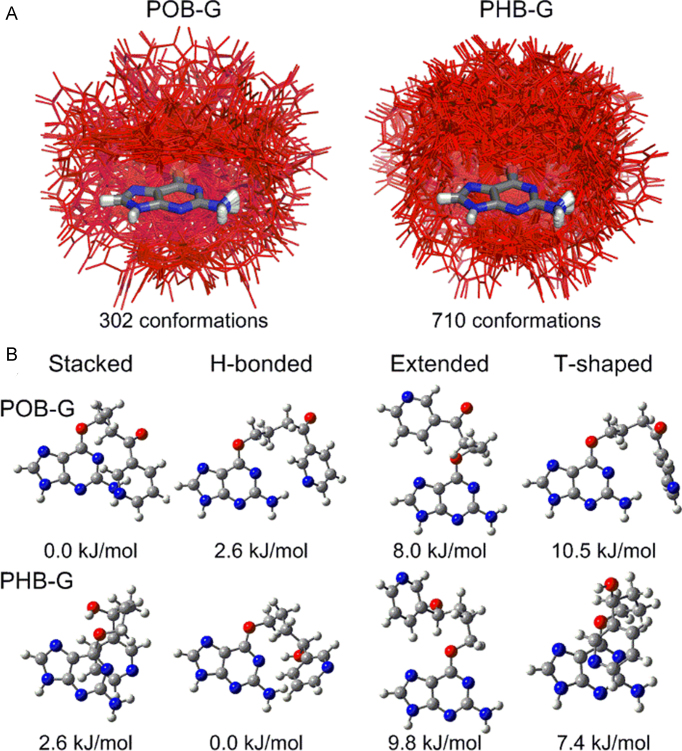
(A) Overlay (based on G ring atoms) of POB-G (left) and PHB-G (right) conformations identified using DFT, with the bulky moiety highlighted in red. (B) Most stable POB-G (top) and PHB-G (bottom) structures identified for each conformational category (relative energies provided). POB-G nucleobase geometries adapted from reference (31).